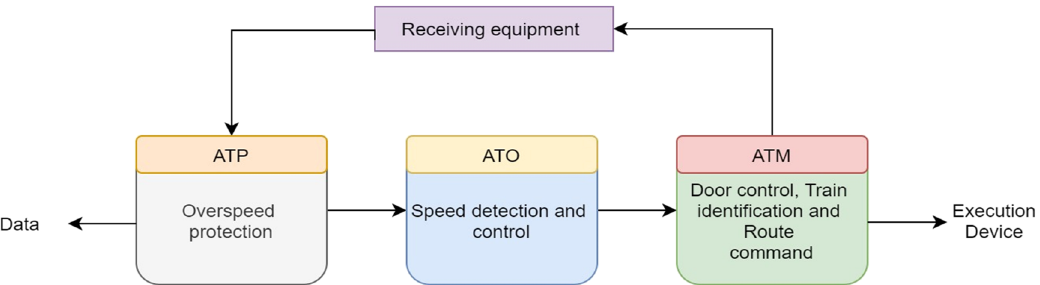
Figure 1: Diagram of system control